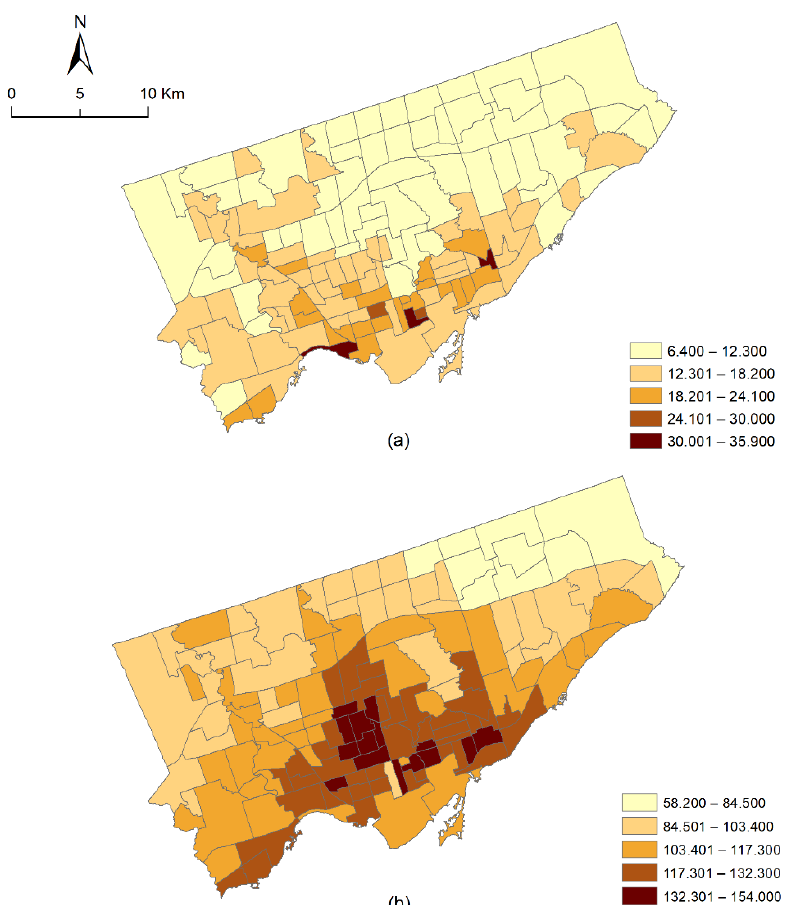
Figure 1. The age and sex standardized rates of ( a ) psychotic and ( b ) non-psychotic